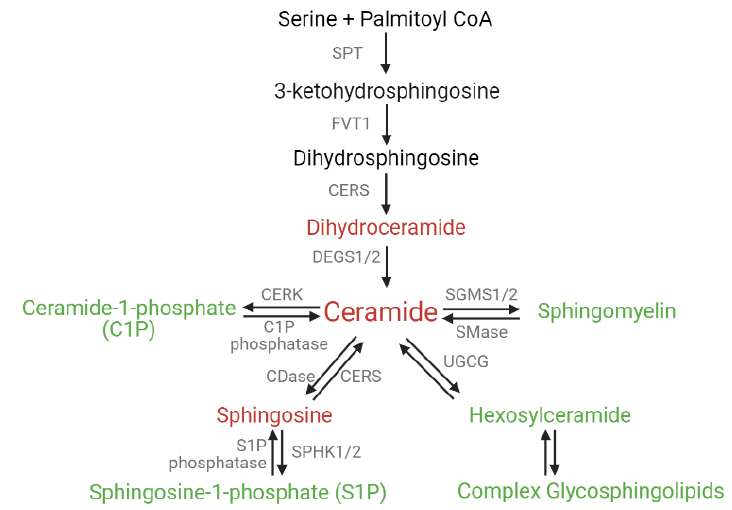
Figure 2. Ceramide production and turnover pathways. Enzymes are depicted in gray. Pro-apoptotic sphingolipids are depicted in red, and pro-proliferative sphingolipids are depicted in green. Diagram was created with Biorender.com.